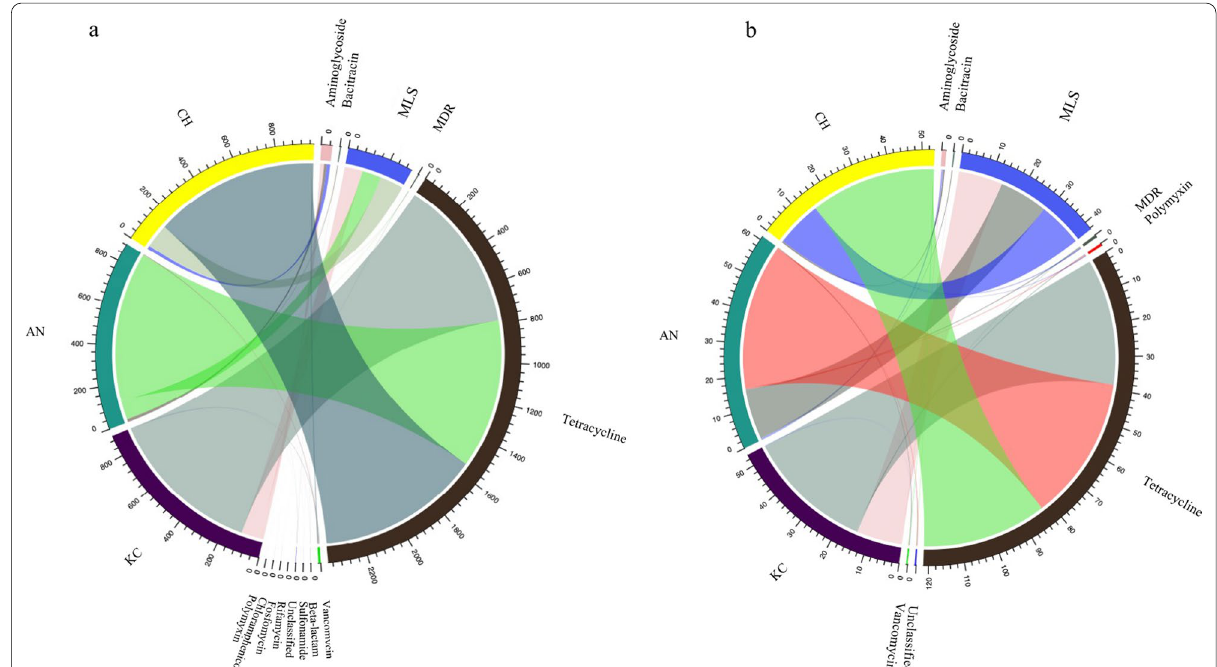
Fig. 3 Abundance (normalized into reads per million of reads) of classes of ARGs and ARG transcripts in the rumen of KC, CH, and AN beef steers. a Abundance of 13 classes of ARGs. b Abundance of 8 classes of expressed ARGs. ARG, antimicrobial resistant gene; KC, Kinsella composite hybrid; AN, Angus; CH, Charolais; MLS, macrolide-lincosamide-streptogramin; MDR,